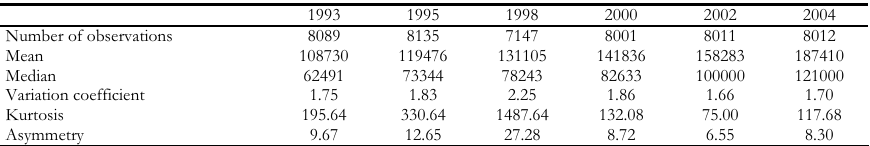
Real wealth of Italian households from 1993 to 2004, thousand euro